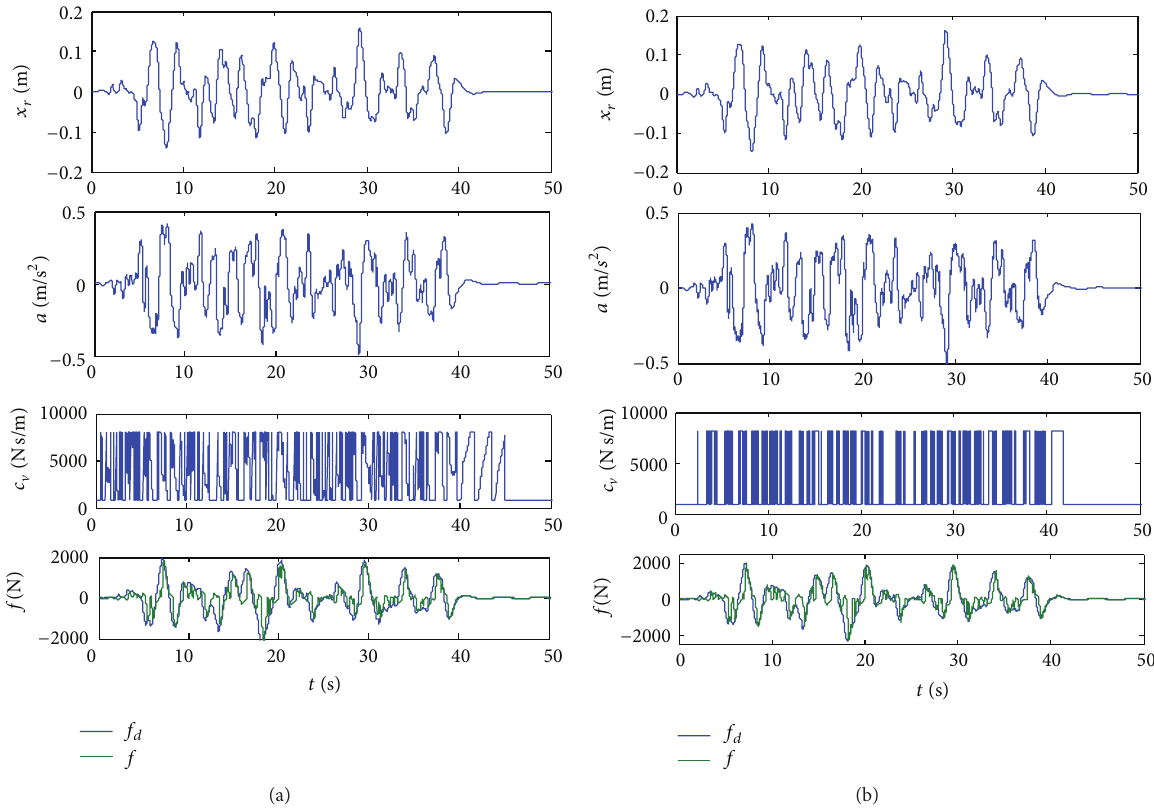
Figure 8: Simulation results for the SDOF model ( 𝑓 𝑛 = 0.25 Hz and 𝜉 = 10 % ) subjected to one type 1 accelerogram employing SA systems with 𝑇 𝑠 = 5 ms, HP = 50 , HC = 1 , 𝑟 = 1 , and 𝑑 = 10 , with both VD (a) and COO (b) control